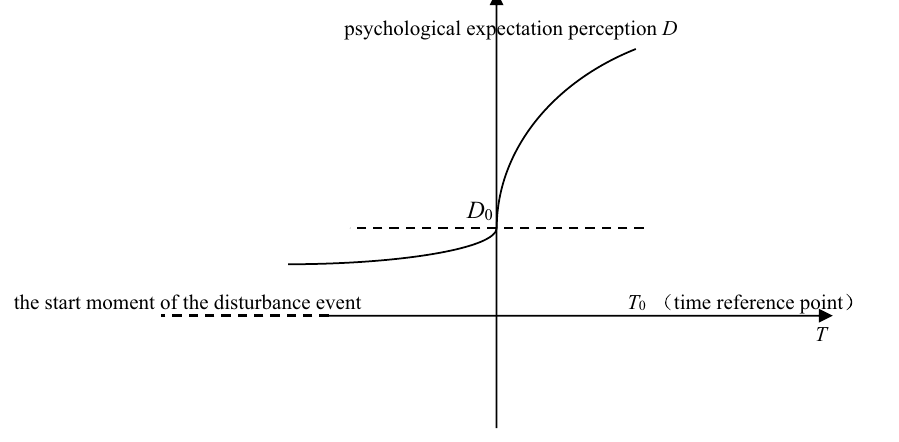
Figure 1. The psychological expectation perception curve chart 16